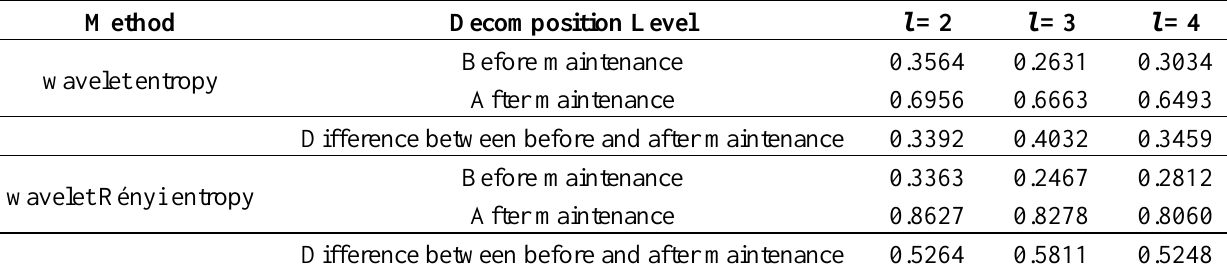
Table 3. Operational safety assessment with wavelet Rényi entropy in comparison with wavelet